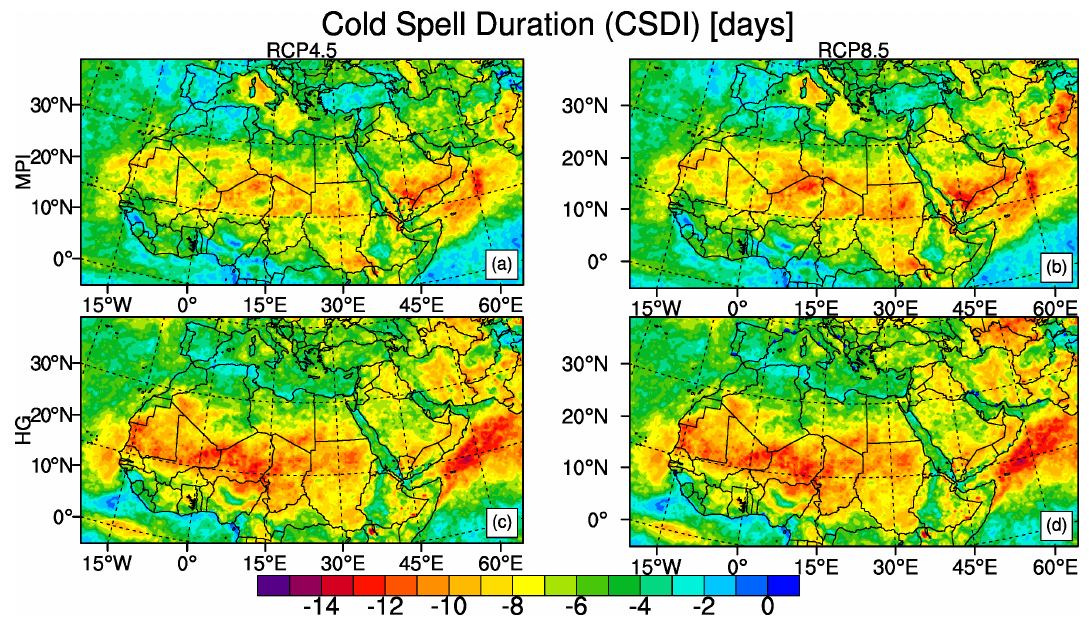
Figure 5. The temporally averaged changes in CSDI for the period of 2071–2100 displayed as differences (in days) with respect to the reference period 1971–2000 for the model MPI-ESM-MR with RCP4.5 ( a ) and RCP8.5 ( b ) and for the model